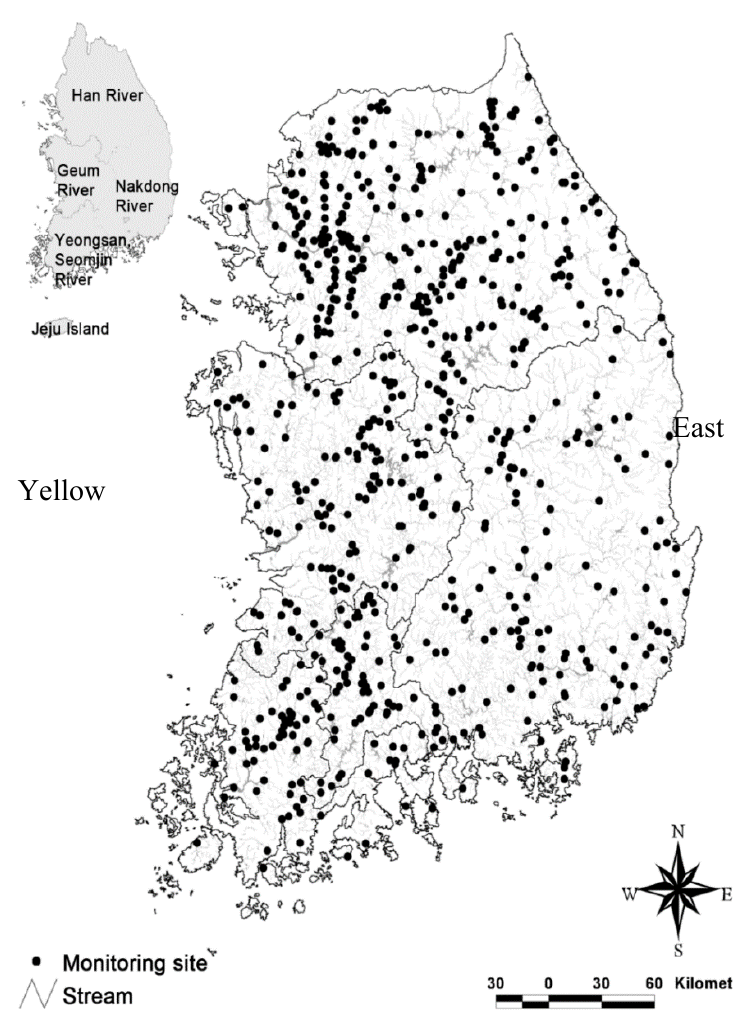
Figure 1. The five major river systems and the locations of National Aquatic Ecological Monitoring Program (NAEMP) monitoring sites. Most streams on the east side can be characterized by a short length, low water temperature, and fast flow rate.